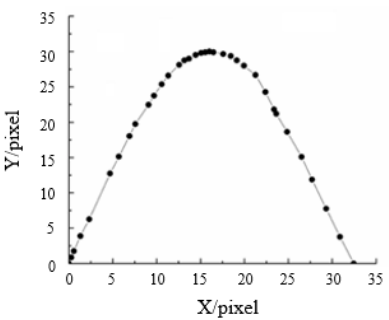
Figure 2. The fitting curve of the crickets’ upper jaw incisor lobe.